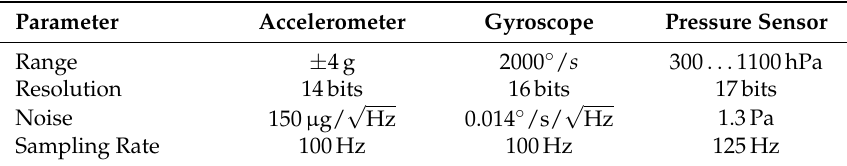
Table 2. Characteristic parameters of the IMU sensor nodes implemented for the